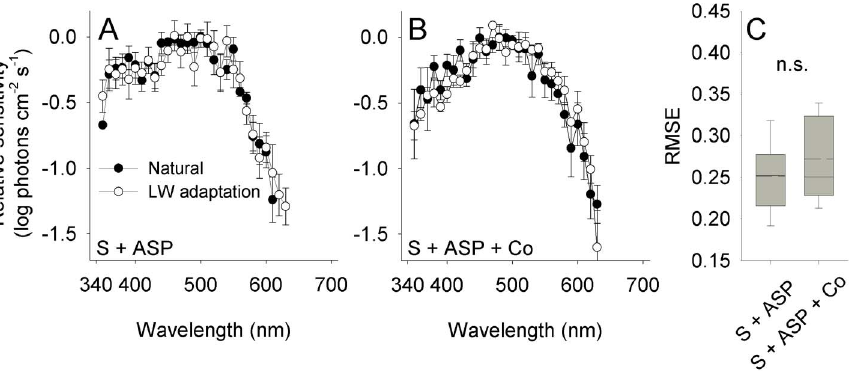
Figure 3. HC-cone feedback does not affect the efficiency of color induction in the photoresponse of cones. (A,B) Spectral sensitivity of the photoresponse of cones measured from retina treated with saline and aspartate (S + ASP), and from retina treated with saline, aspartate and cobalt (S + ASP + Co). A sensitivity peak in the ultraviolet region (ca. 370 nm) in the S + ASP-treated retina disappeared following the application of cobalt. Error bars, 6 1 SEM. Sample size: S + ASP: Natural=5, LW adaptation=5; S + ASP + Co: Natural=5, LW adaptation=4. (C) The efficiency of color induction, as indicated by the root mean square error (RMSE) between the spectral sensitivity under the two backgrounds, did not vary significantly with the application of cobalt that inhibits HC-cone feedback (denoted n.s.; see text for statistics). Box: mean (dashed), median (solid), 25 th and 75 th percentiles; whiskers: 10 th and 90 th percentiles.